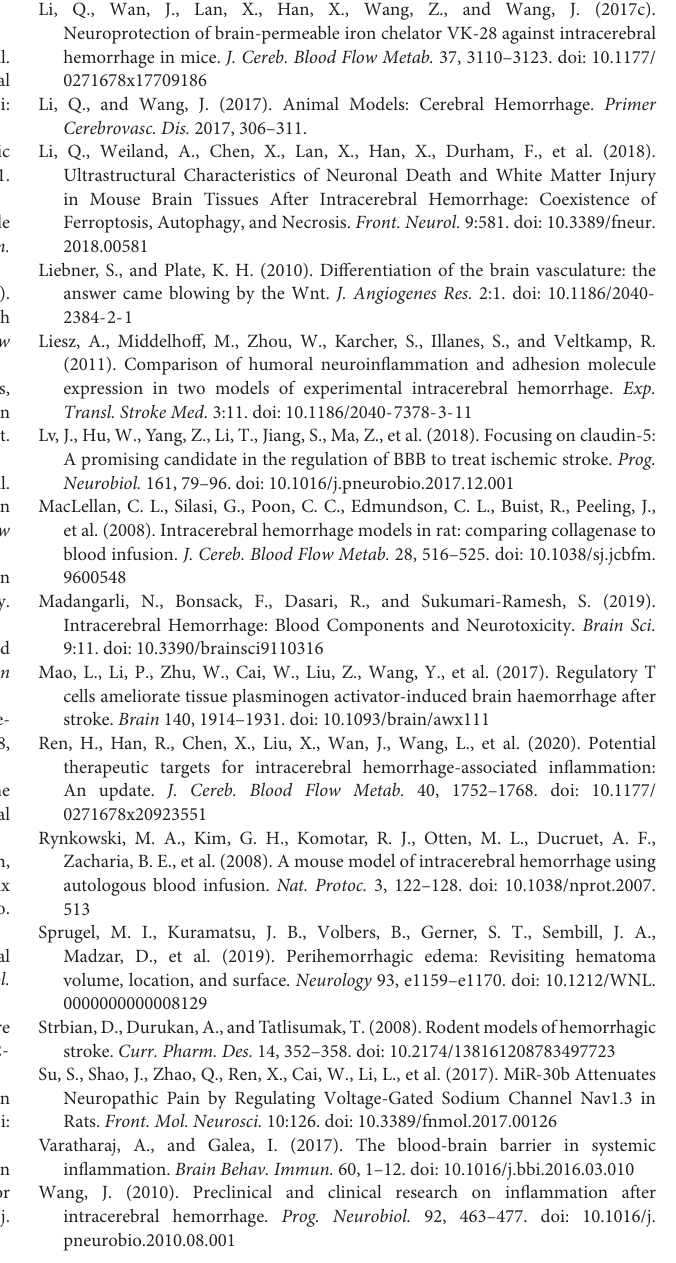
Supplementary Figure 1 | Experimental design route. NFE, Neurologic function evaluations; EB, Evans’s blue; WB, Western blot; TEM, Transmission electron microscope; GEZ, Gelatin gel zymography; CV-LFB, cresyl violet and Luxol fast blue; HIA, Hemorrhagic injury analysis; IgG ET, IgG extravasation